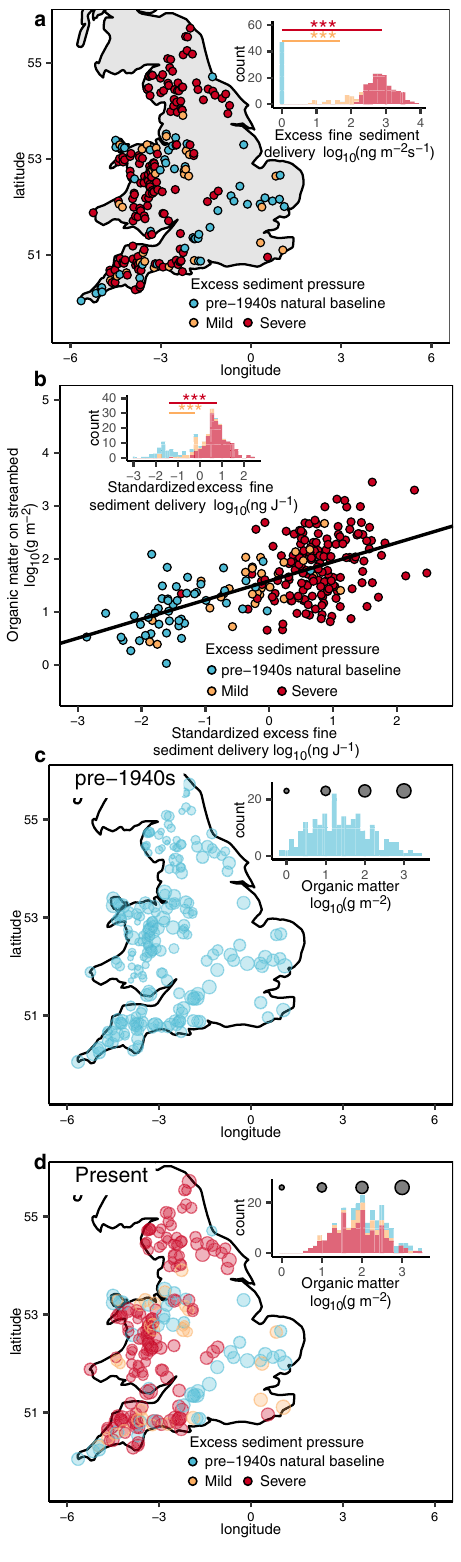
Fig. 1 Excess fi ne-sediment delivery into streams increases organic matter on streambeds ( n = 236 streams). a The majority of streams that we sampled in England and Wales (80%, 189 out of 236 streams) are under mild to severe excess fi ne-sediment pressure, equivalent to 48-fold and 758- fold increases, respectively, in fi ne sediment relative to the pre-1940s natural baseline ( t -statistic, ***: P <0.001). b Standardizing excess fi ne sediment delivery to speci fi c stream power, reveals a positive correlation between streambed organic matter and standardized excess fi ne-sediment